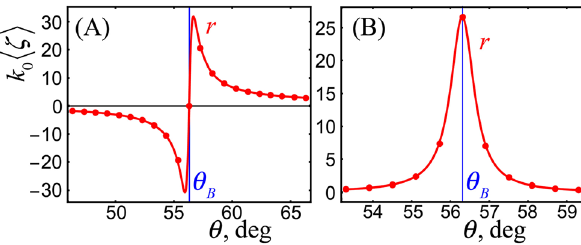
Figure 4: Resonant weak-measurement enhancement of the longitudinal shifts (time delays) of the reflected STVPs for near- p = (1 , 0 . 01) in the vicinity of the Brewster angle input polarization e 0 of incidence in the cases (A) and (B). Parameters are: 𝓁 = 1, n = 1 . 5, 𝛾 = 0 . 4, k Δ = 0